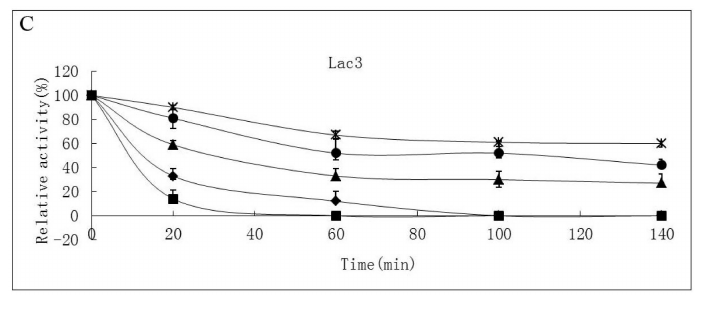
Figure 4. Stability of purified P. nebrodensis laccases at different temperatures ( A ) Effect on Lac1; ( B ) Effect on Lac2; ( C ) Effect on Lac3. “-x-” curves: treatment at 30 ˝ C; “- -” curves: treatment at 40 ˝ C; “- (cid:78) -” curves: treatment at 50 ˝ C; “- (cid:7) -” curves: treatment at 60 ˝ C; “- (cid:4) -” curves: treatment at 70 ˝ C. Measurements were carried out in triplicate (standard deviations for all data points < 5%).